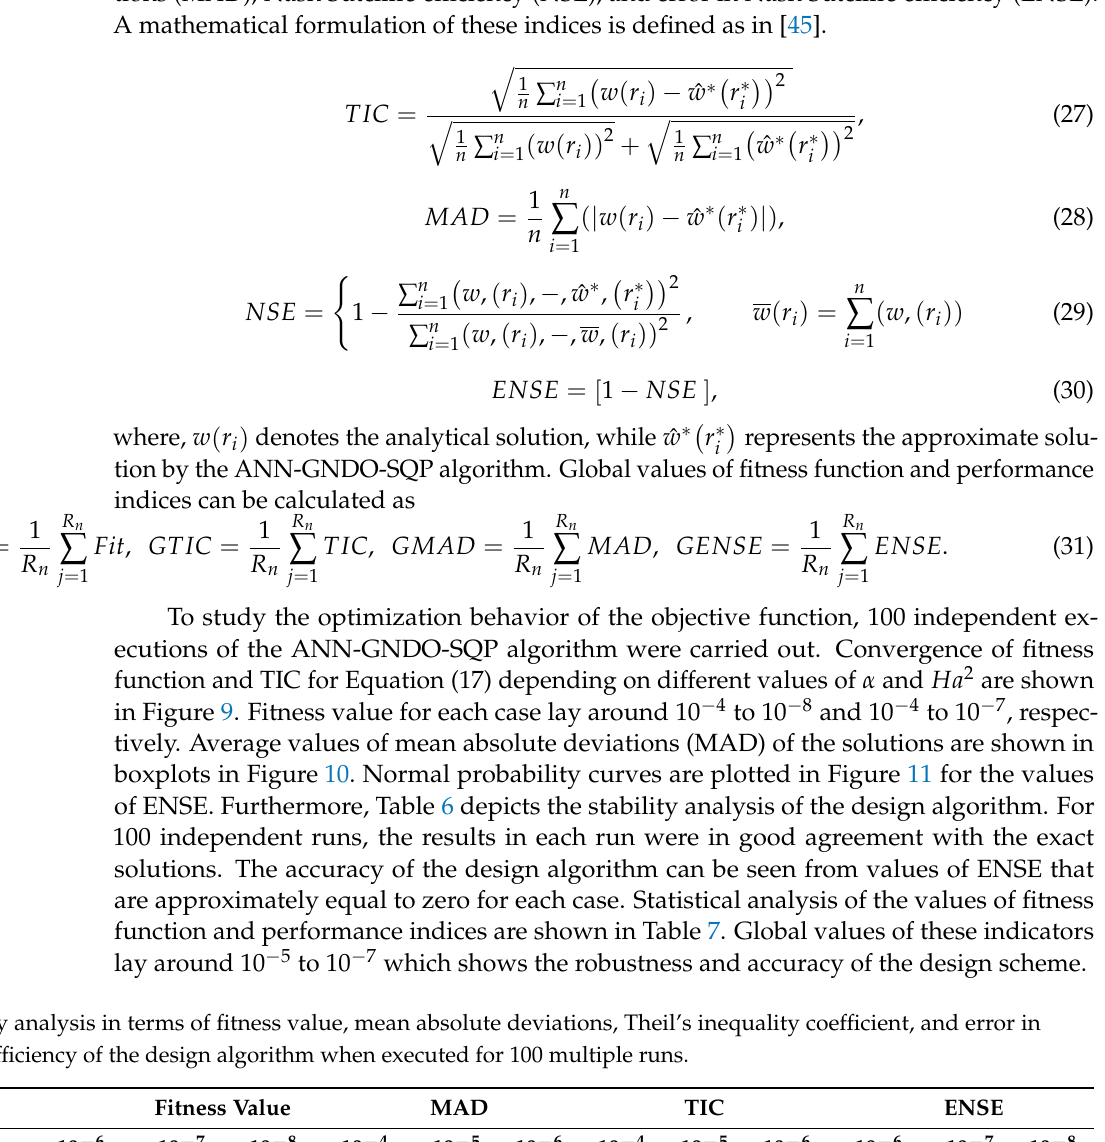
Ha 2 = α = 0.5 100 Ha 2 = α = 1.0 Ha 2 = α = 2.0 99 Ha 2 = 6, α =